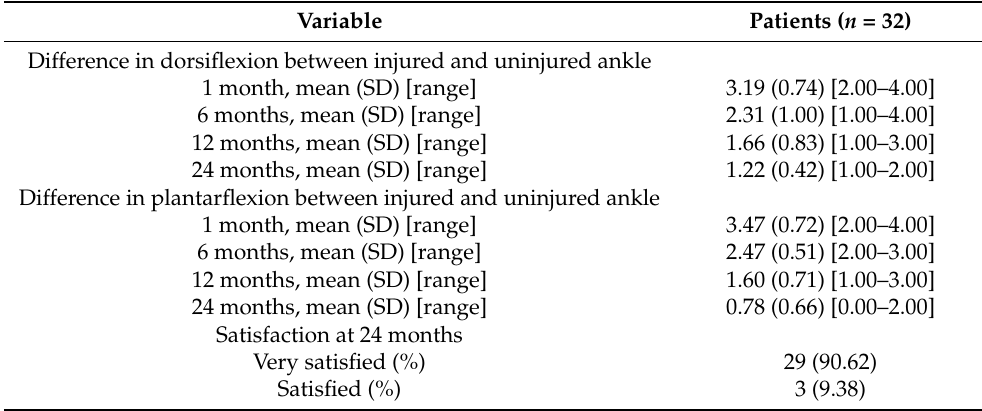
Table 2. Postoperative functional tests and patient